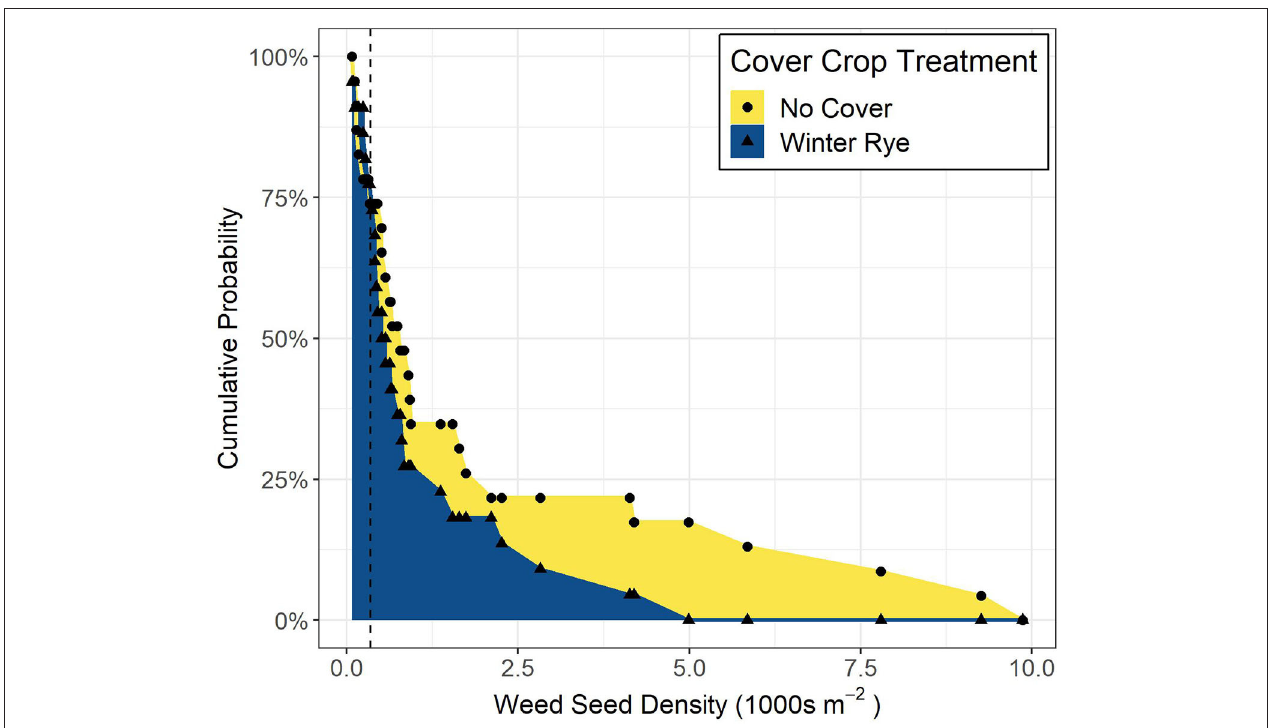
FIGURE 4 | Each point represents the cumulative probability of having a weed seedbank of that density or higher; as seedbank densities increase above 300 seeds m − 2 (dashed line), the probability of having a larger seedbank is higher for no-cover systems compared to cover-cropped systems; the area under the curve is proportional to the risk of increasing weed seedbank